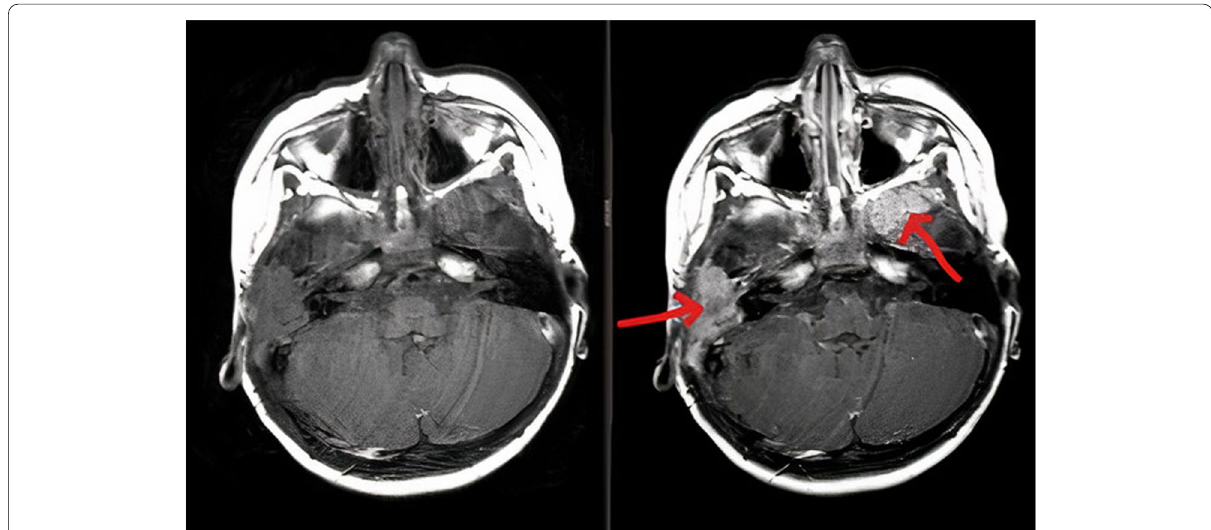
Fig. 2 Axial pre- and post-contrast T1W images show a tumor in the right temporal and sphenoid bone (arrows)